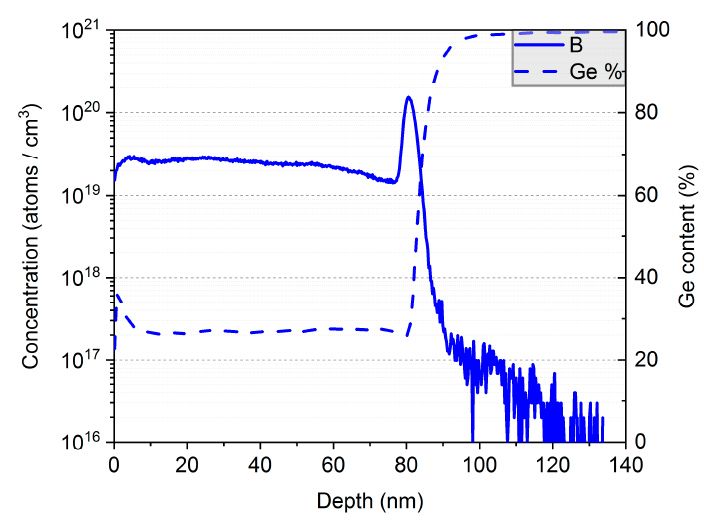
Figure 3. Secondary ion mass spectroscopy (SIMS) analysis on 80 nm thick p + -Si 0.73 Ge 0.27 layer grown on Ge SRB. Boron dopant concentration is 2.5 × 10 19 atoms/cm 3 . The peak for the B concentration around 80 nm layer depth is due to dopant segregation at the SiGe/Ge interface. The Ge content of the SiGe layer is 27%.